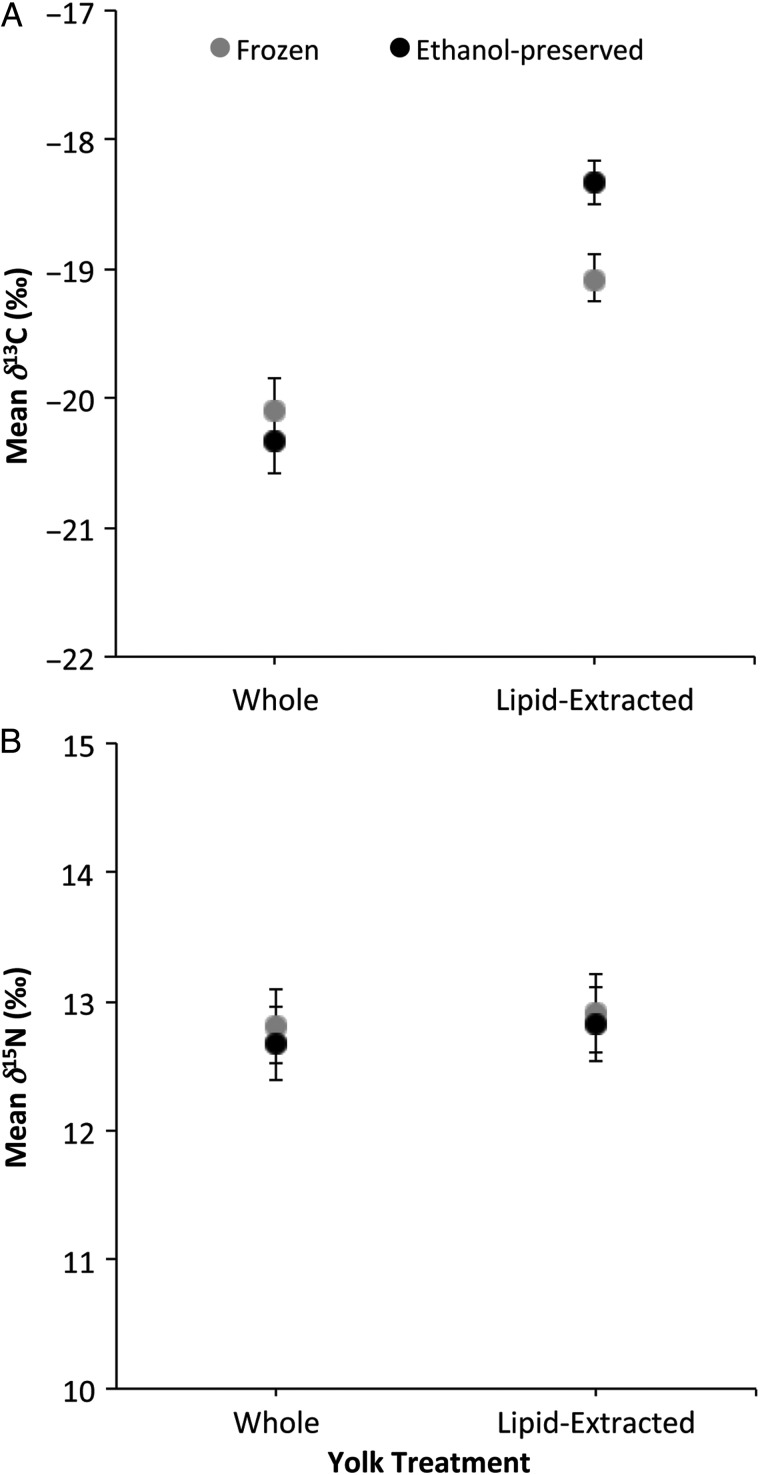
Mean ± SEM δ13C (A) and δ15N values (B) of whole (not lipid-extracted) and lipid-extracted yolks with two preservation treatments, frozen and ethanol preserved. Lipid extraction and ethanol preservation exhibited an interaction effect for δ13C values but not for δ15N values.